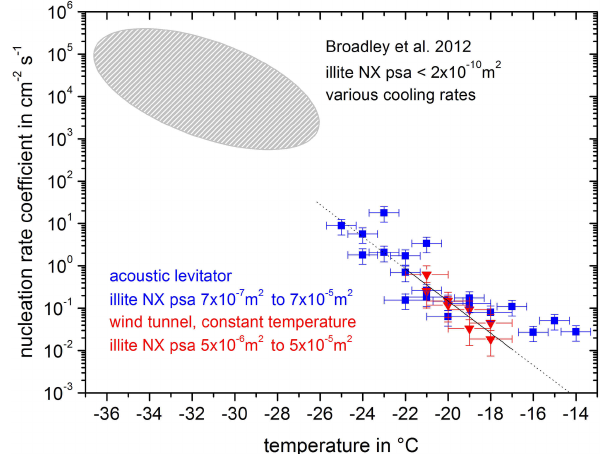
Figure 9. Nucleation rate coefficients as functions of temperature for illite NX derived from present (shown in blue and red) and pre- vious experiments (indicated as grey region, from Broadley et al.,